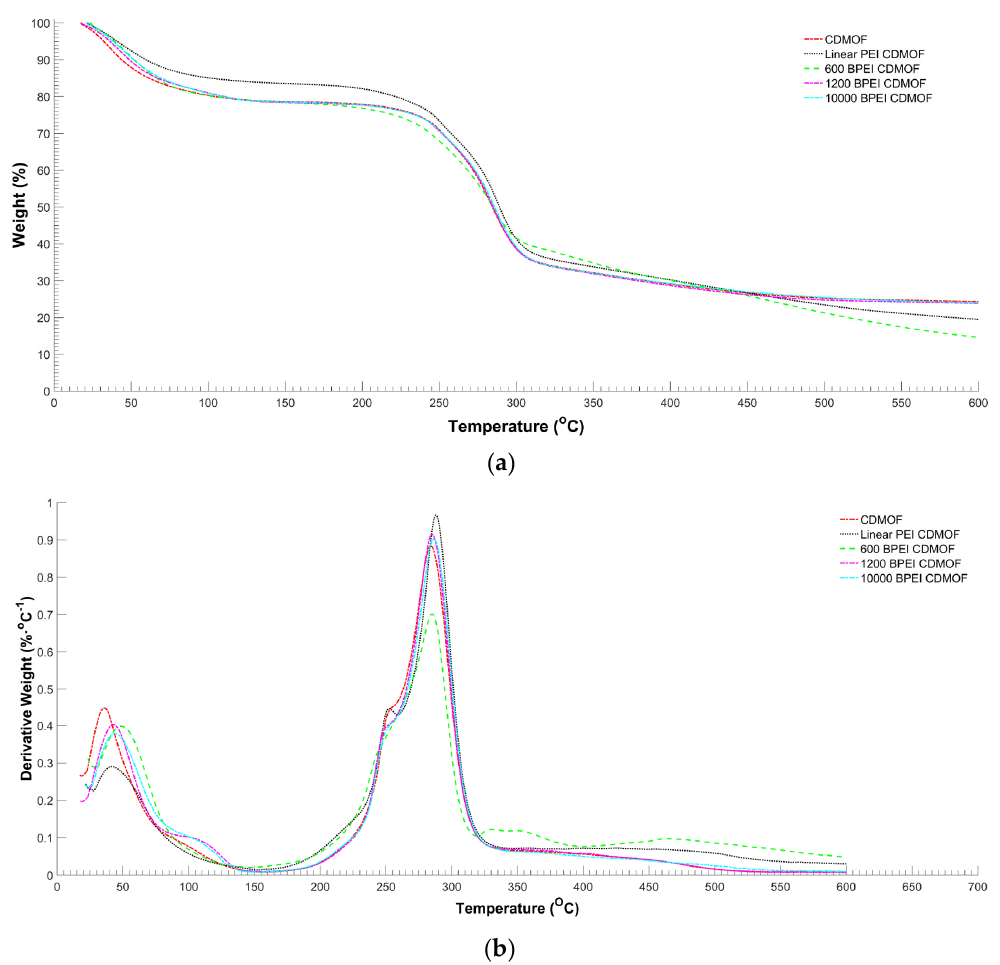
Figure 6. TGA data for control and PEI loaded γ -CD-MOFs ( a ) TGA Thermogram, and ( b ) Derivative profile of the tested PEI- γ -CD-MOFs combinations .